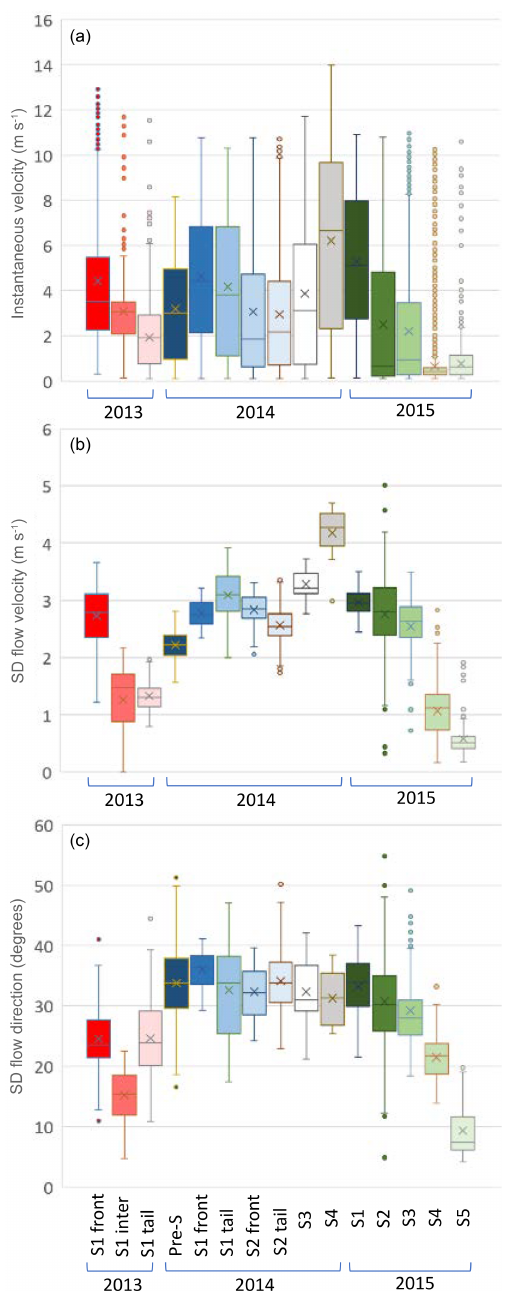
Figure 4. LSPIV velocity (a) , velocity variation ( T v ; b ), and direc- tional variation ( T d ; c ) comparisons for 2013, 2014, and 2015 surges located at the same cross